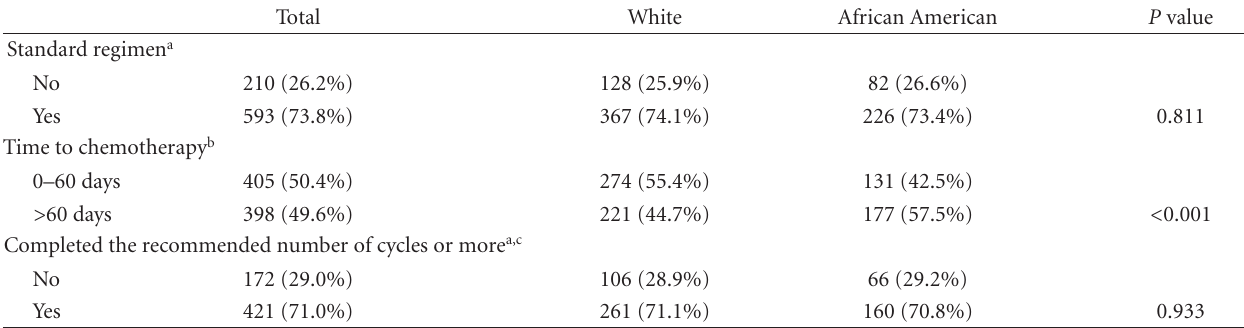
Table 4: Racial di ff erences in the use of standard adjuvant chemotherapy and timing of chemotherapy administration.